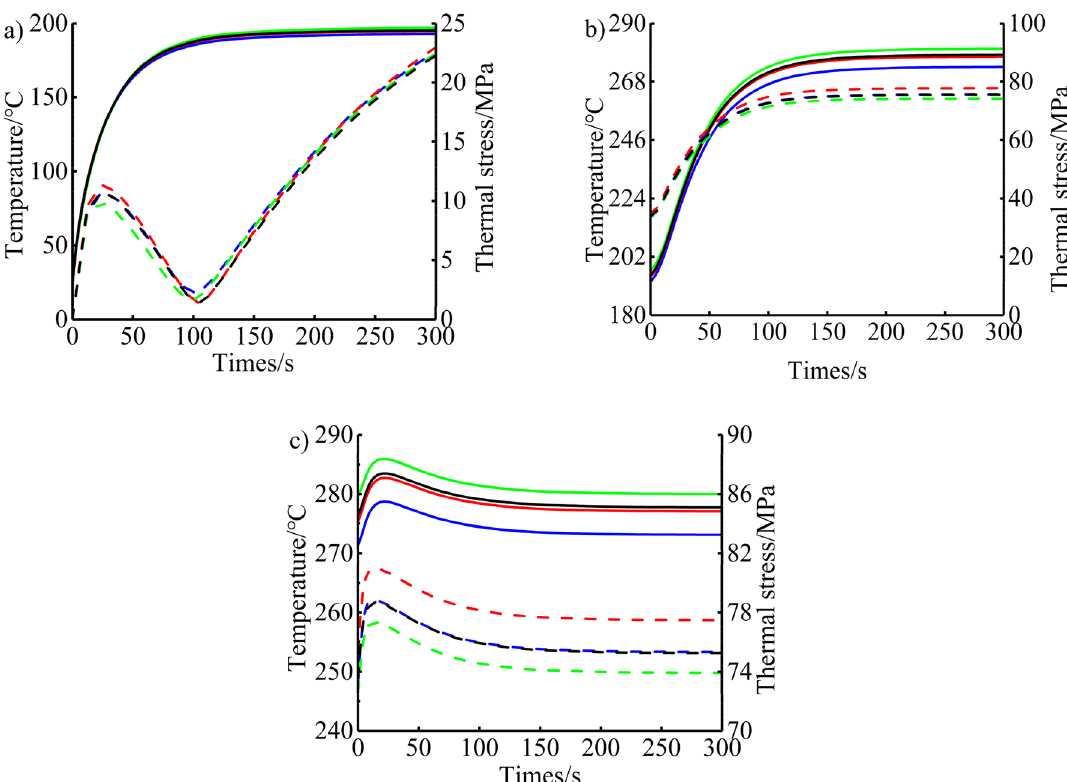
Figure 16. Temperature and thermal stress distribution of the first ring groove under the ( a ) cold start condition, ( b ) urgent acceleration condition and ( c ) rapid deceleration